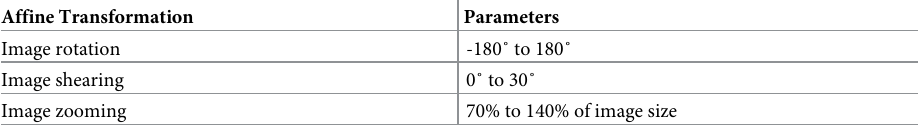
Table 5. Data augmentation performed to train the